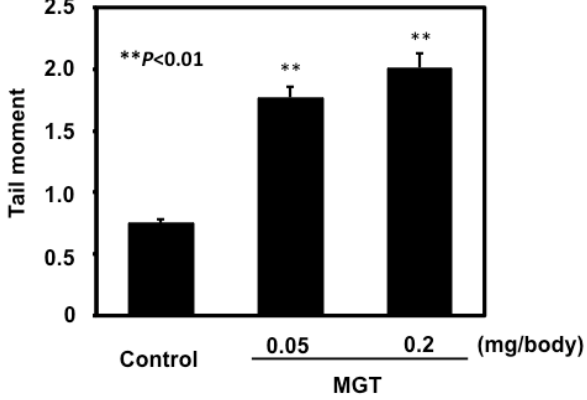
Figure 2. DNA damage in the lungs of imprinting control region (ICR) mice intratracheally instilled with MGT. DNA damage was measured by comet assay. Male mice were treated at a dose of 0.05 mg or 0.2 mg of particles per animal, and sacrificed 3 h after particle administration. The values represent the means of data for five animals ± SE. vehicle control mice.